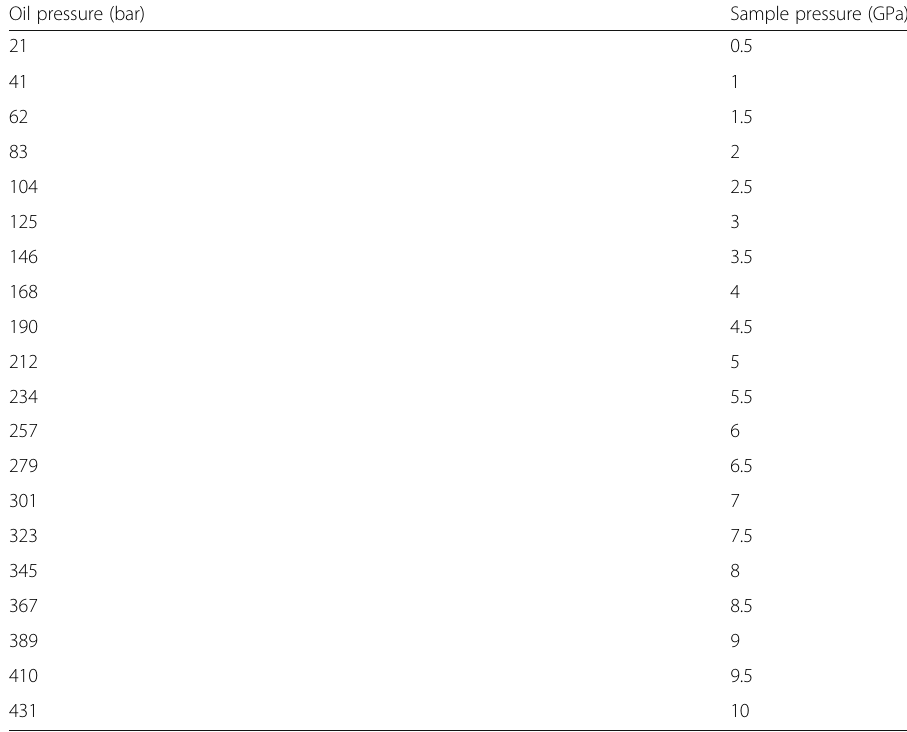
Table 2 A list of points on the calibration curve Oil pressure